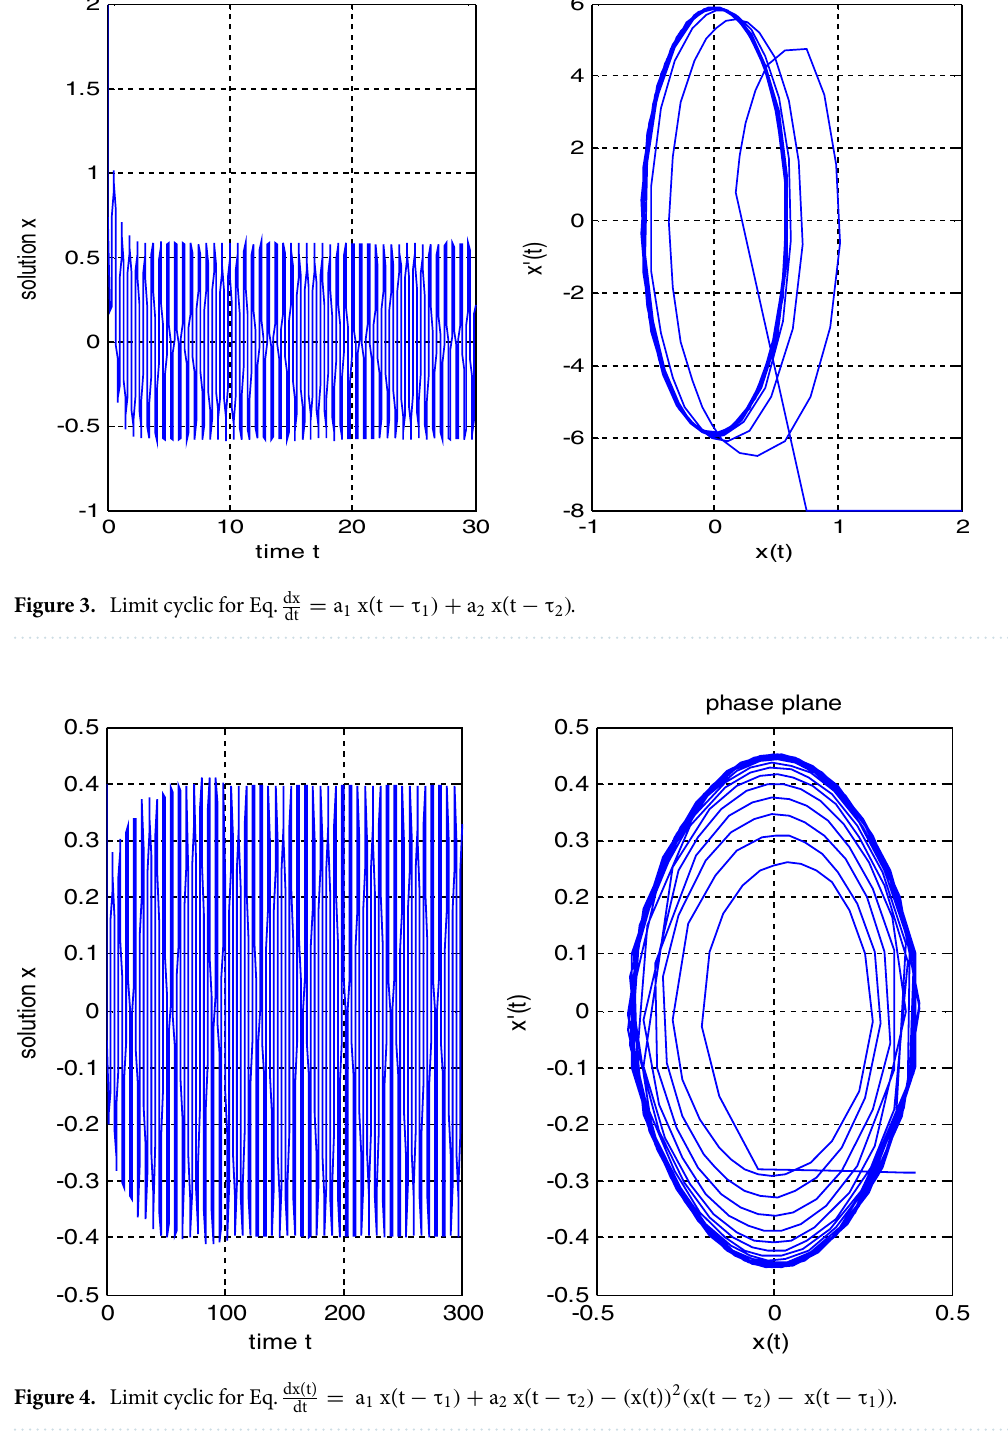
Figure 4. Limit cyclic for Eq. dx(t) dt